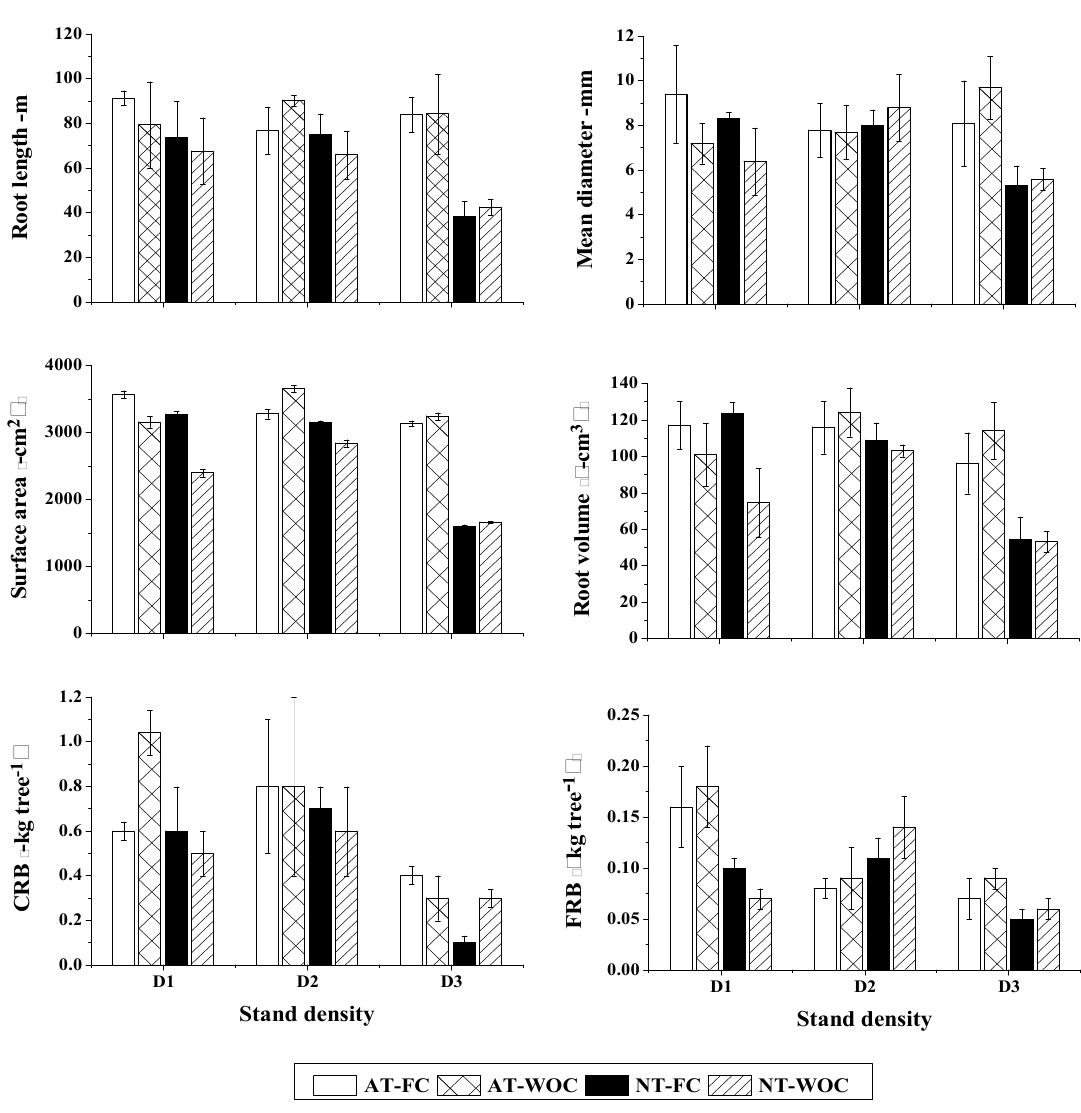
Figure 6. Distribution of root morphological traits of average and neighboring trees in competition and non-competition zones in the studied Chinese fir plantation. AT-FC and AT-WOC represent part of the root system of average trees (AT) in competition (FC) and non-competition (WOC) zones, respectively, and NT-FC and NT-WOC represent part of the root system of neighboring trees (NT) in competition and non-competition zones, respectively. CRB and FRB stand for coarse root biomass and fine root biomass, respectively.